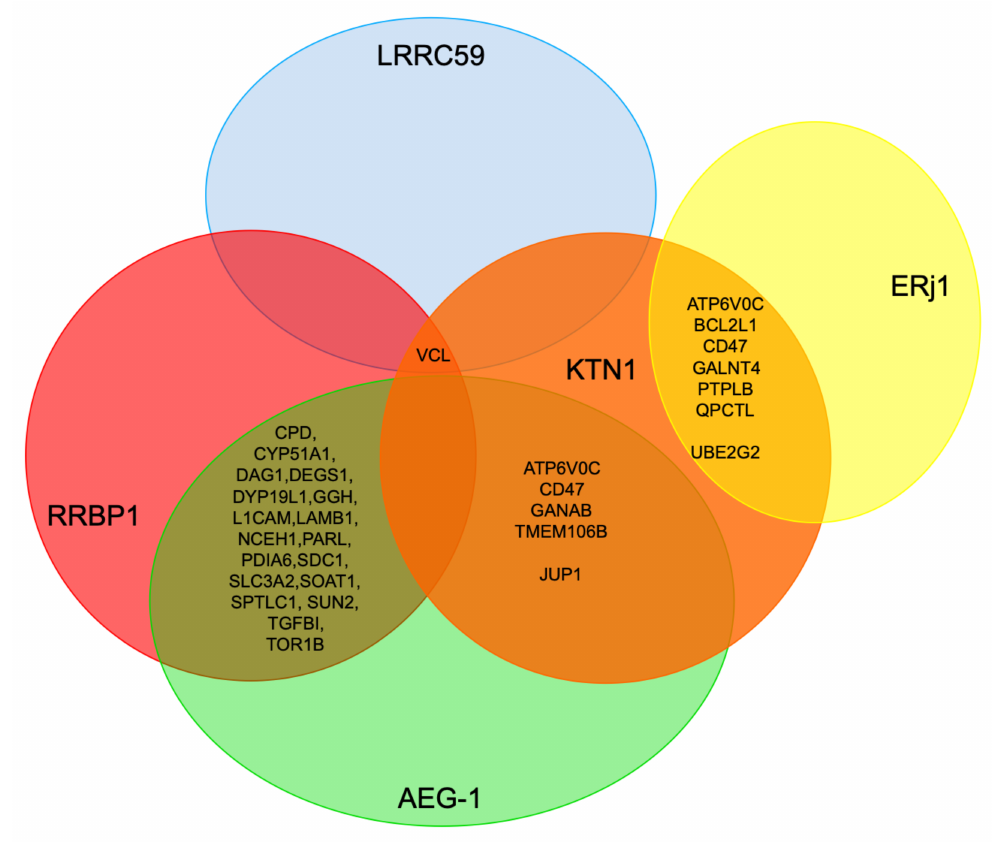
Figure 11. Venn diagram for the overlap of client mRNAs between various mRNA receptors of the ER membrane and ERj1. In addition, COL4A2 was negatively affected by depletion of RRBP1 and